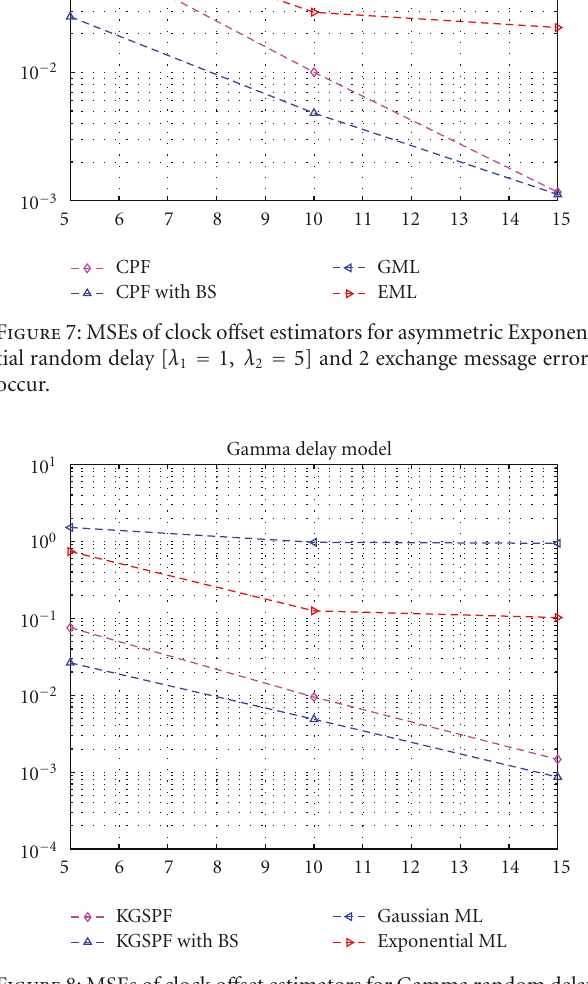
Figure 6: MSEs of clock o ff set estimators for asymmetric Gaussian random delay [ σ 1 = 1, σ 2 = 4] and 2 message exchange errors.